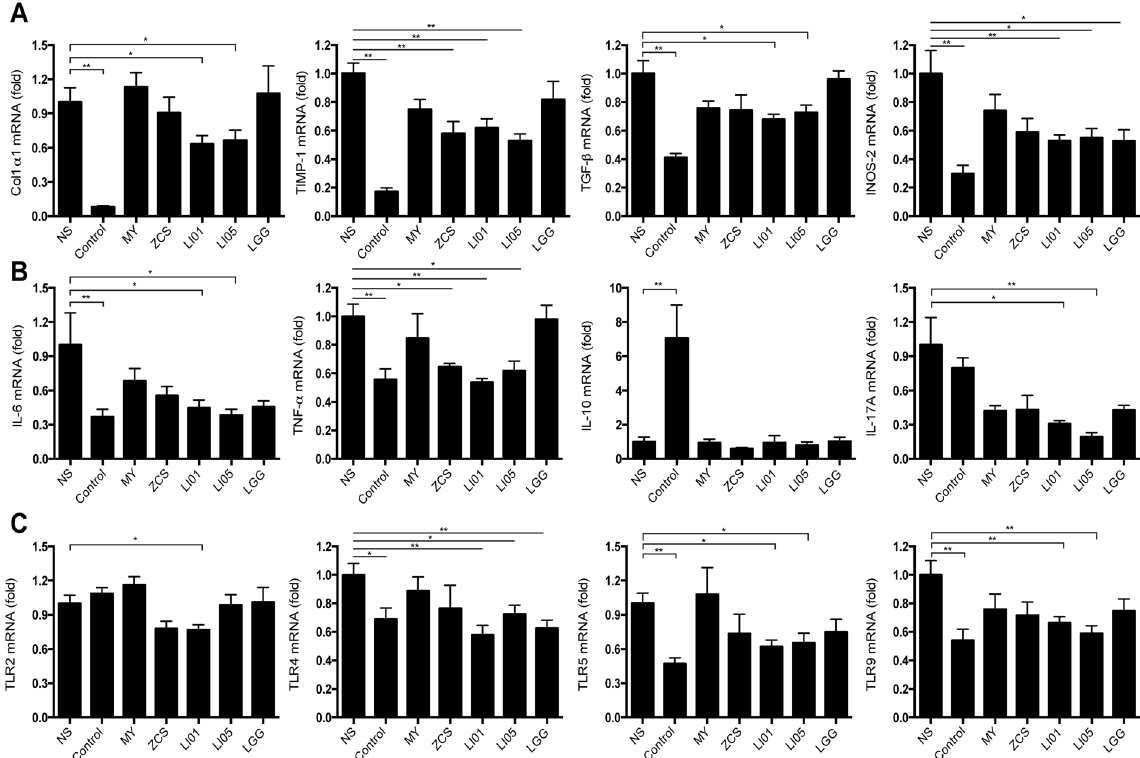
Figure 2. Treatment with L. salivarius LI01 or P. pentosaceus LI05 improved the inflammatory response and down-regulated profibrogenic genes and TLR family gene expression. ( A ) Hepatic expression of the profibrogenic genes Collagen α 1, TIMP-1, TGF- β , and iNOS-2. ( B ) Hepatic expression of the inflammatory cytokines TNF- α , IL-6, IL-10 and IL-17A. ( C ) Hepatic expression of the TLR family members TLR2, TLR4, TLR5 and TLR9. Gene expression was determined by quantitative PCR analysis of the total mRNA extracted from liver fragments. Results are expressed as fold change relative to NS group. All data are given as the mean ± SEM. * P < 0.05 and ** P < 0.01 vs. normal saline-treated cirrhotic rats in the NS